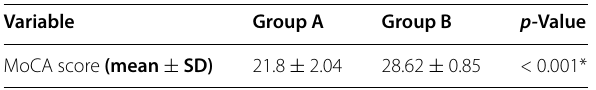
Table 3 Comparison of MoCA scores between cannabis users and nonusers using Z -test